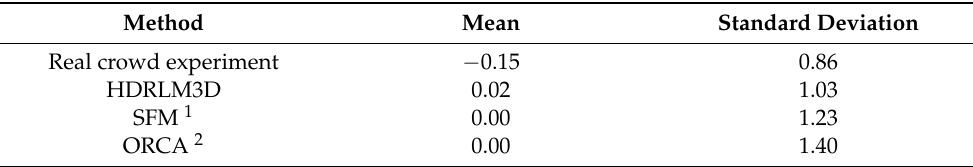
Table 3. Mean and standard deviation of different methods.